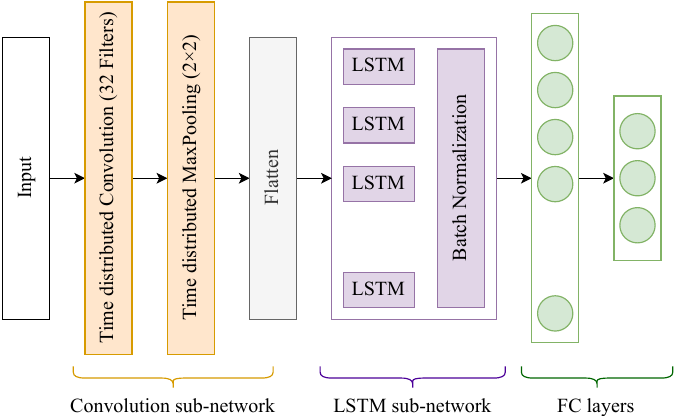
Figure 4. Architecture of the neural network used for classifying sequences generated by the variation 1 of our classification algorithm.